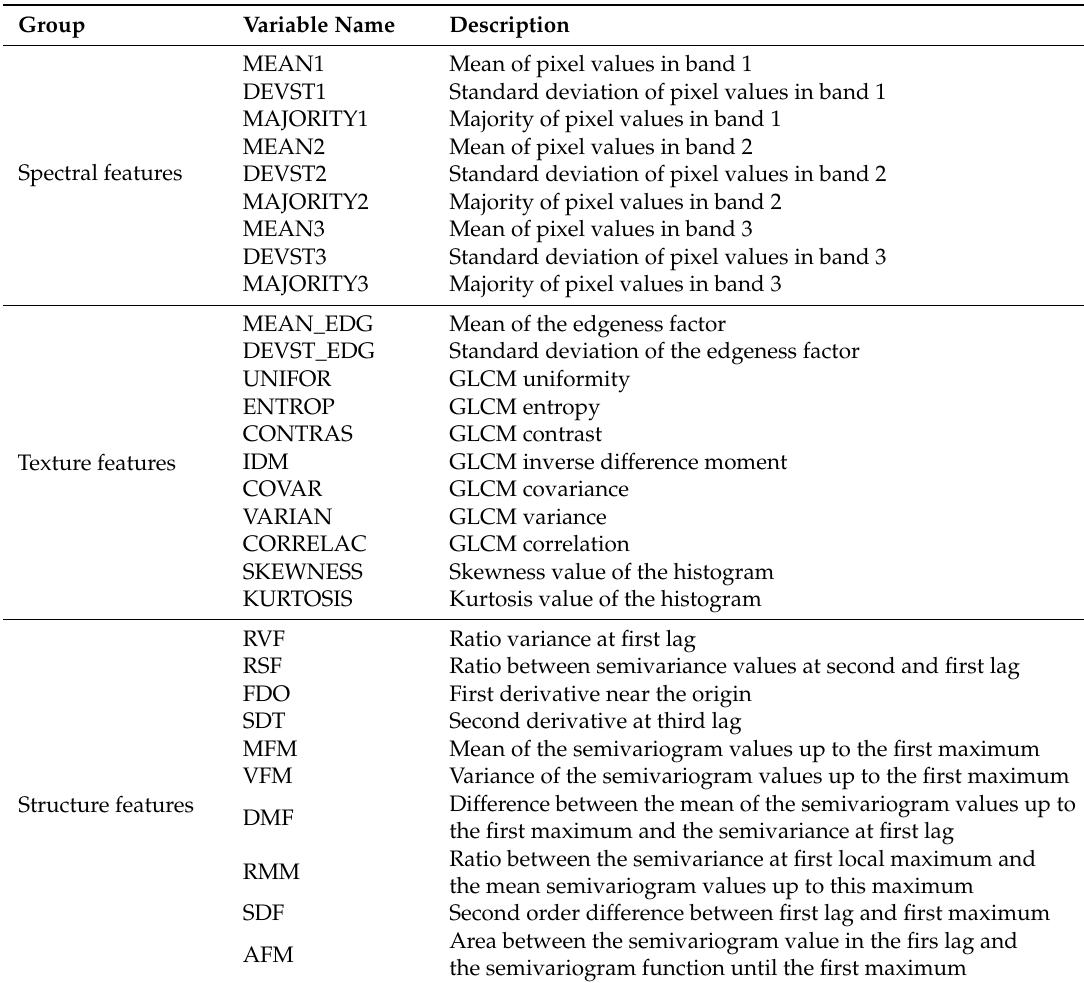
Table 2. Image-derived